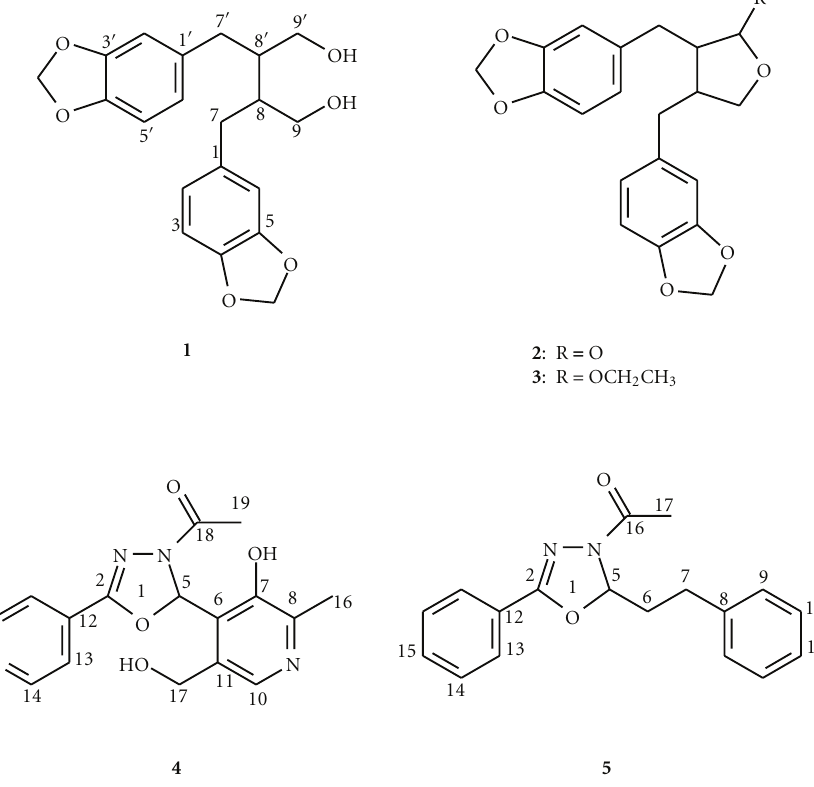
Figure 1: Lignans from V. flexuosa ( 1, 2, and 3 ) and synthetic oxadiazolines ( 4 and 5 ).